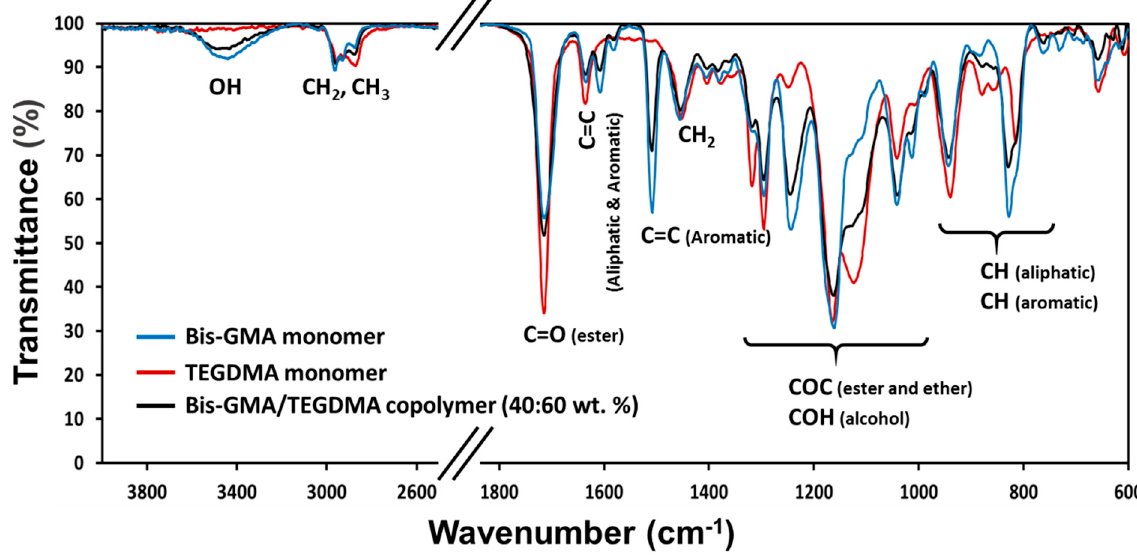
Figure 4. FTIR spectra of Bis-GMA/TEGDMA copolymer in the PICN sample, after curing at 110 °C, and the respective monomers used for the copolymer synthesis.